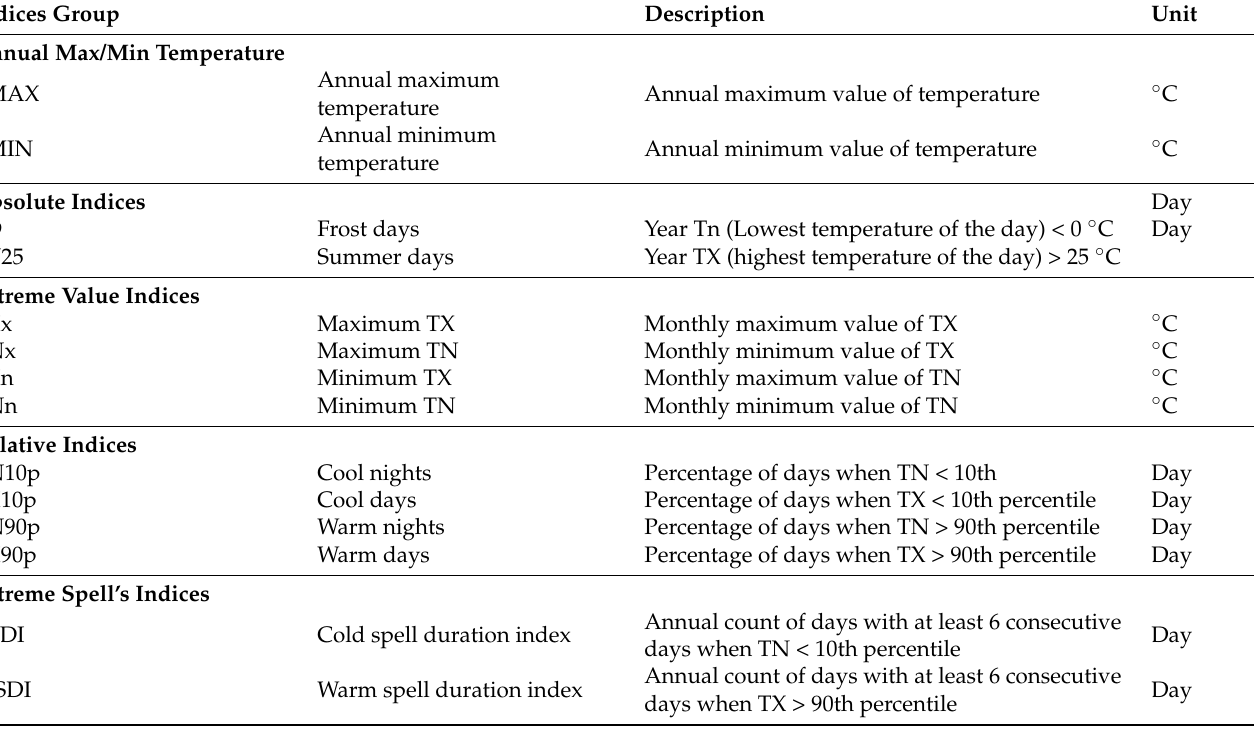
Table 2. Groups of temperature